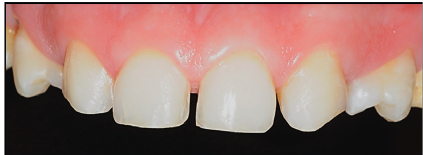
Figure 8: Clinical situation after finishing the wear and polishing steps.